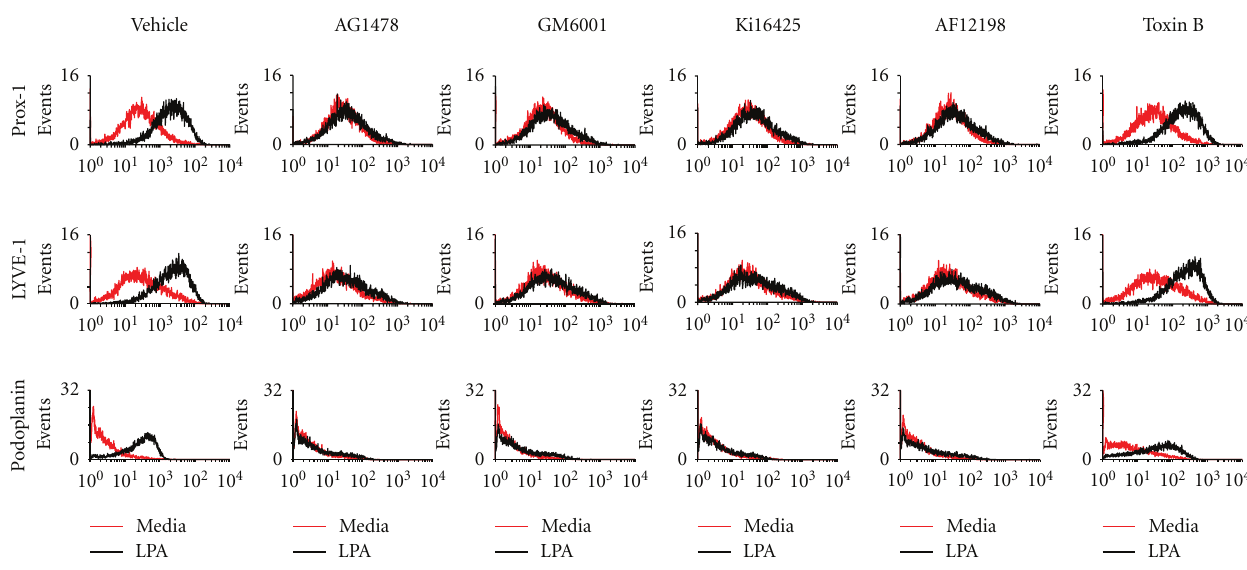
Figure 1: Lysophosphatidic acid- (LPA-) induced lymphatic marker expressions are mediated through endothelial growth factor receptor (EGFR) transactivation-, matrix metalloproteinase- (MMP-), LPA1/3-, and interleukin- (IL-) 1R-dependent pathways in human umbilical vein endothelial cells (HUVECs). Starved HUVECs were pretreated with AG1478 (100 nM), AF12198 (10nM), GM6001 (10 μ M), Ki16425 (10 μ M), and toxin B (10nM) for 1h, followed by LPA (5 μ M) treatment for an additional 8 h. HUVECs were dissociated by trypsinization and fixed with 4% paraformaldehyde. Fixed cells were labeled with antibodies for Prox-1, LYVE-1, and podoplanin, and then analyzed by CyFlow. Cells were also stained with a normal mouse or goat immunoglobulin G antibody, which served as a negative